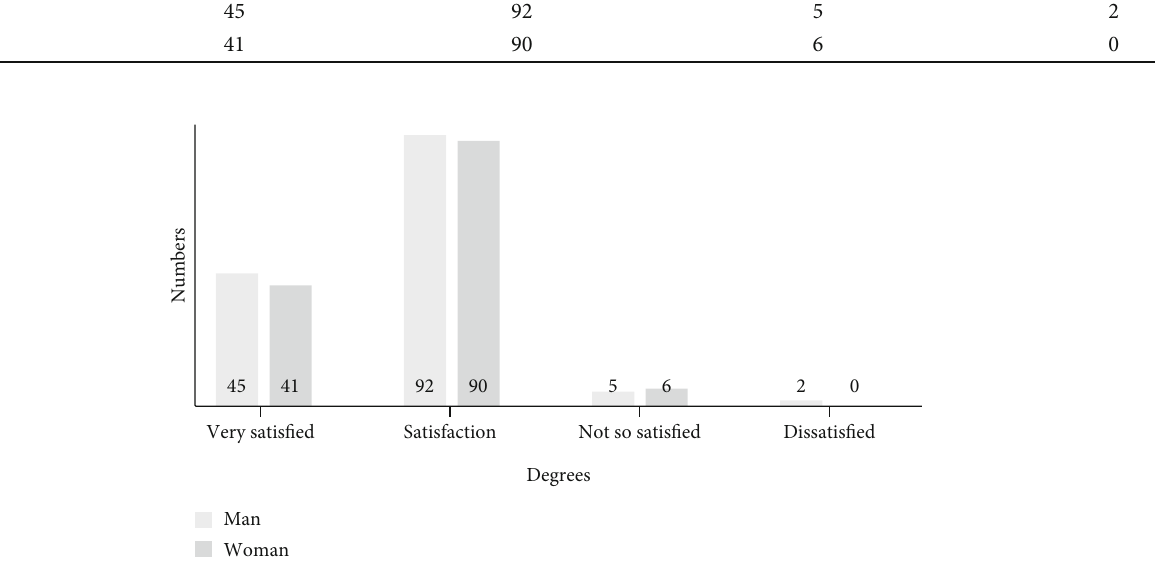
Figure 1: Analysis of teachers ’ teaching ability.